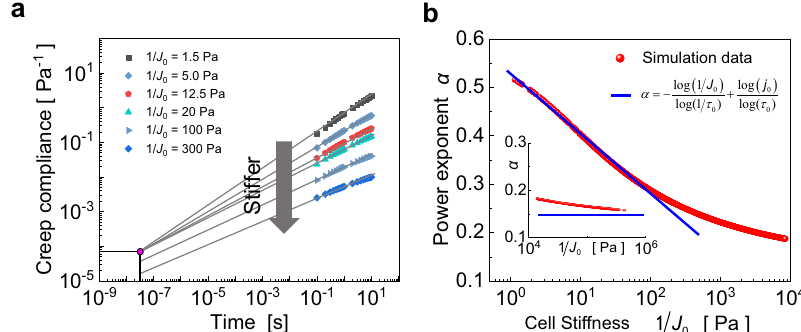
Fig. 5 Relation between power-law exponent and cellular stiffness. a The creep responses of cells with different cell stiffness intersect at one point at relatively low stiffness and become parallel at suf fi ciently high stiffness. b The power-law exponent α versus cellular stiffness 1 = J law exponent when the cell stiffness is high.